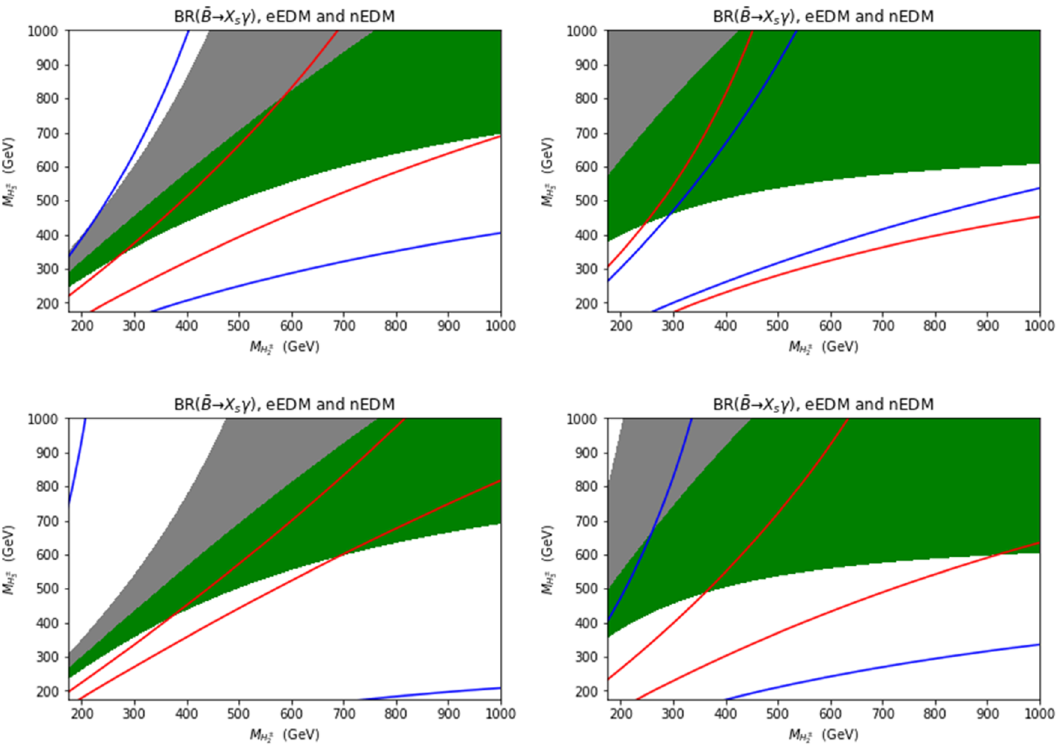
Figure 17 . The allowed regions from ¯ B → X s γ (within the green and grey shaded areas), eEDM (between the blue lines), and nEDM (between the red lines) in the [ M for θ = − 0 . 476 π and δ = 0 . 5 π (i.e., maximal CP violation), with tan β = 20 (upper panels) or 40 (lower panels) and tan γ = 1 (left panels) or 2 (right